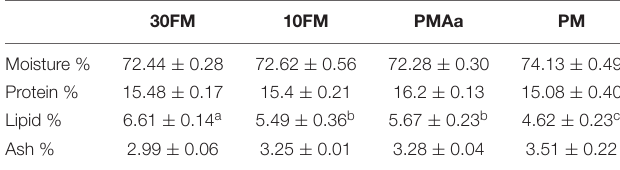
TABLE 7 | Whole-body compositions (fresh weight) of gibel carp fed different experimental diets.